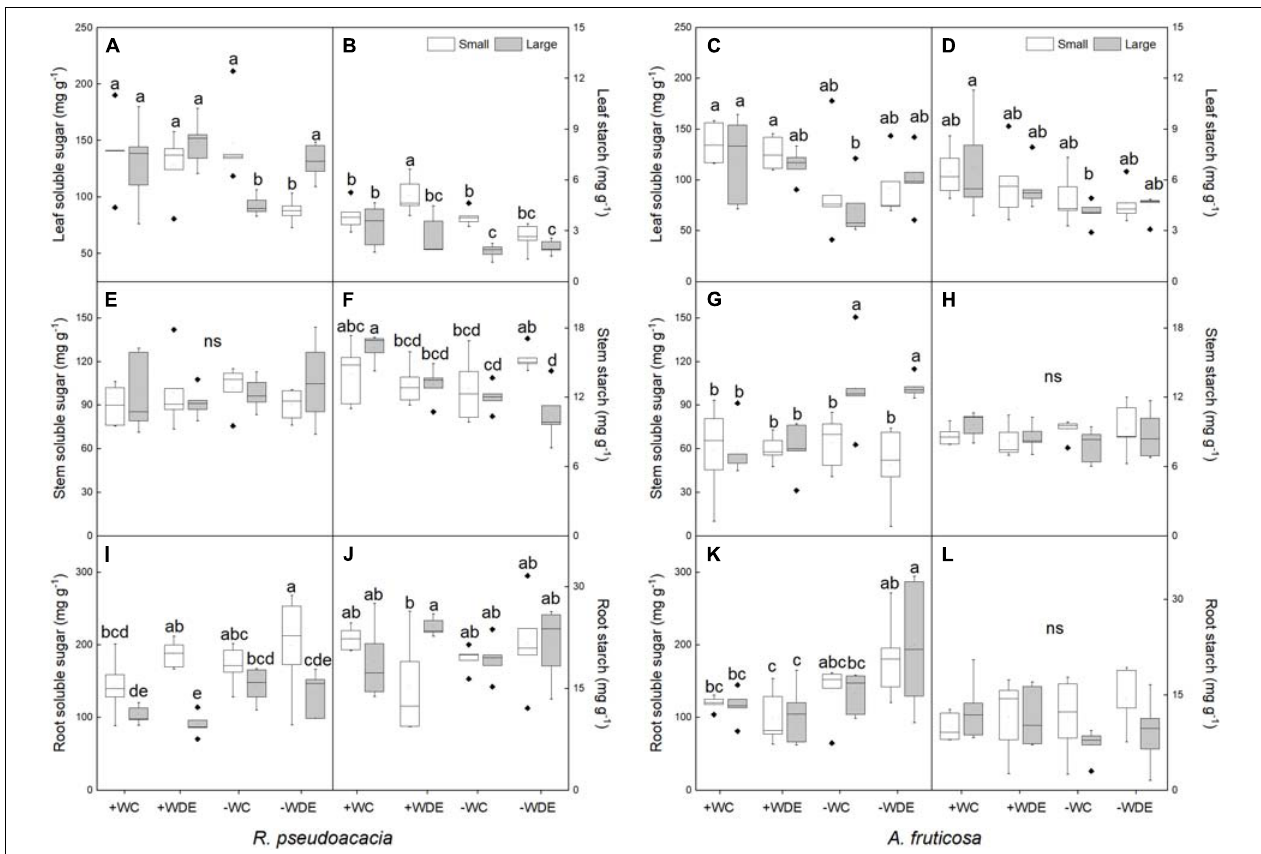
FIGURE 5 | Seedling soluble sugar and starch concentrations in Robinia pseudoacacia (A,B,E,F,I,J) and Amorpha fruticosa (C,D,G,H,K,L) seedlings of two plant sizes under different defoliation and water availability treatments on day 60. The values of the boxplot are the mean of five replicates. Different letters indicate significant differences among different defoliation treatments ( p < 0.05) according to Duncan’s test. +WC, high water availability without defoliation; +WDE, high water availability treatment with defoliation; –WC, low water availability without defoliation; –WDE, low water availability with defoliation.